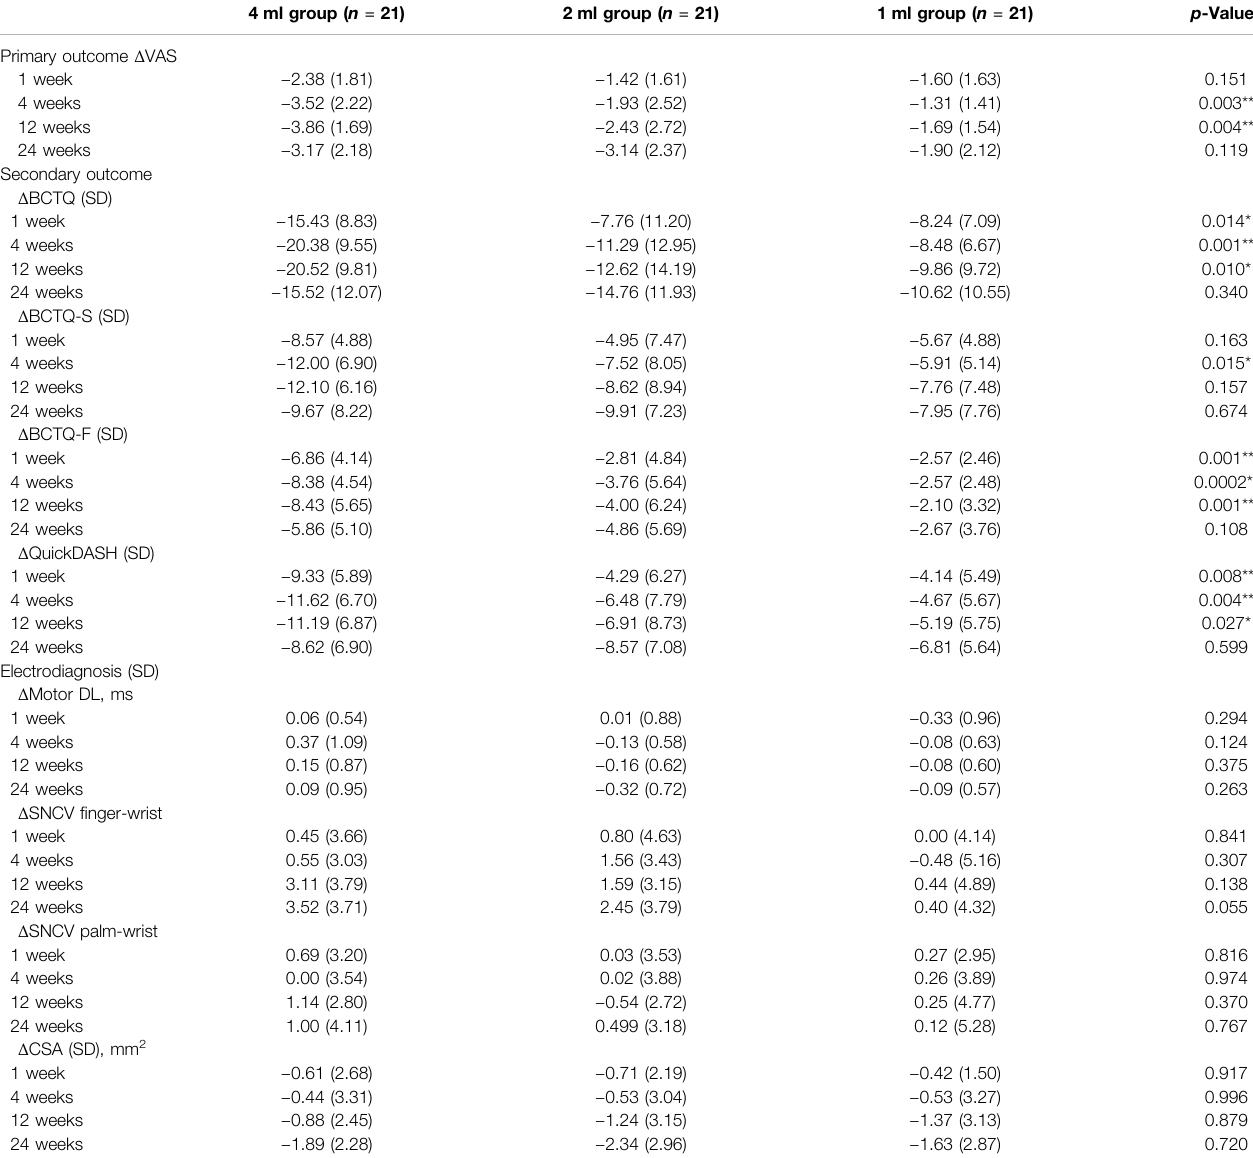
TABLE 3 | Comparison of mean change from baseline in outcomes between three